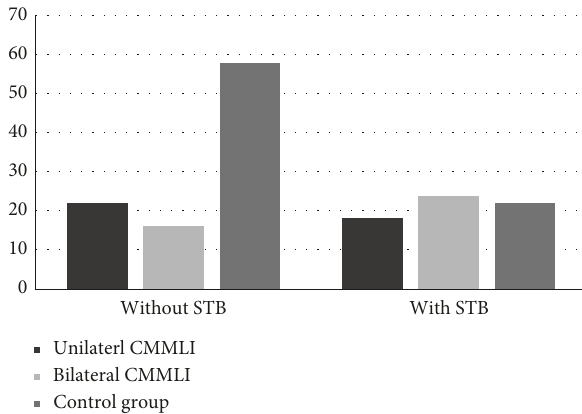
Figure 4: The prevalence of STB in case and control groups ( P � 0 . 06 for unilateral and 0.01 for bilateral compared to the control group).